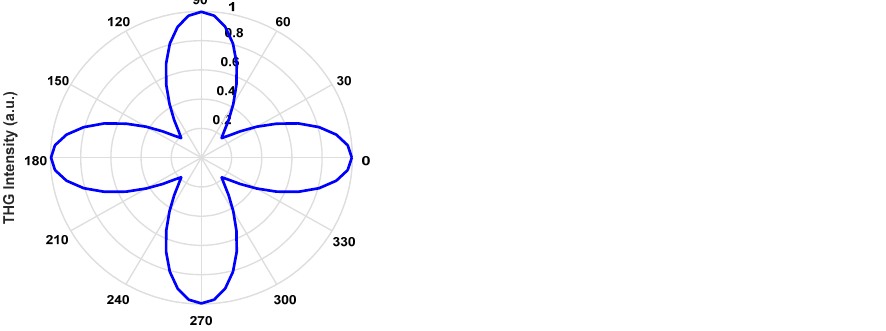
Figure 10. The function of the polarization direction and the intensity of THG in the flat interface.